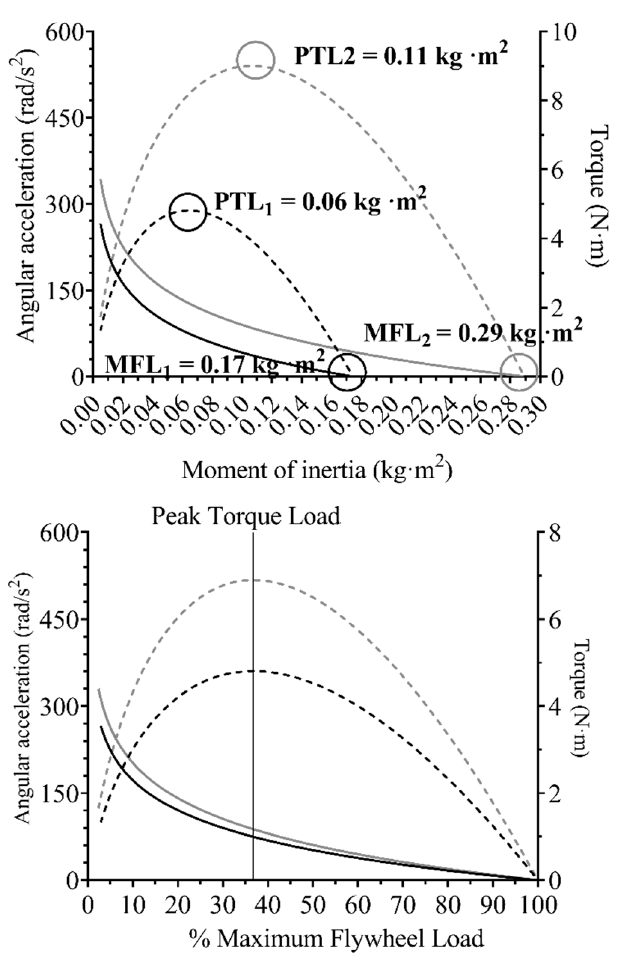
Figure 3. Illustration of the maximum flywheel load index concept. The upper graph shows the acceleration regression line (continuous line) and the torque regression line (dashed line) of a subject with a lower maximum flywheel load (MFL, black color) against a subject with a higher MFL (gray color). MFL is calculated as the intercept of the acceleration curve on the horizontal axis. The lower graph compares both subjects’ profiles using relative intensities instead.